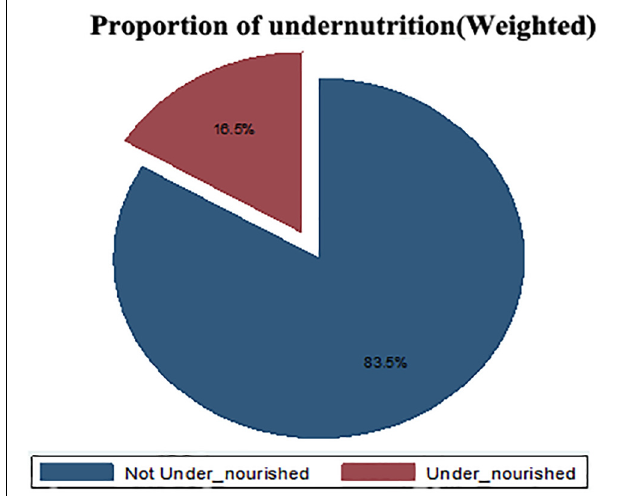
FIGURE 2 | The overall magnitude of under-nutrition among late Adolescents in East African countries from 2010 to 2016.